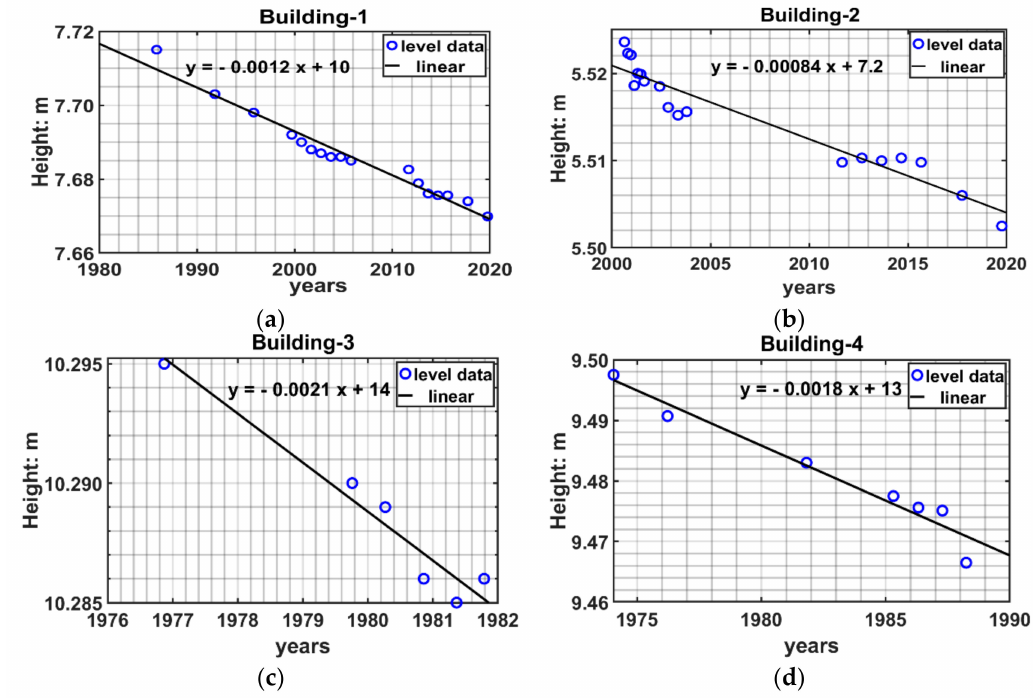
Figure 6. The computed annual displacement rate in mm / yr on the selected leveling pegs, relative